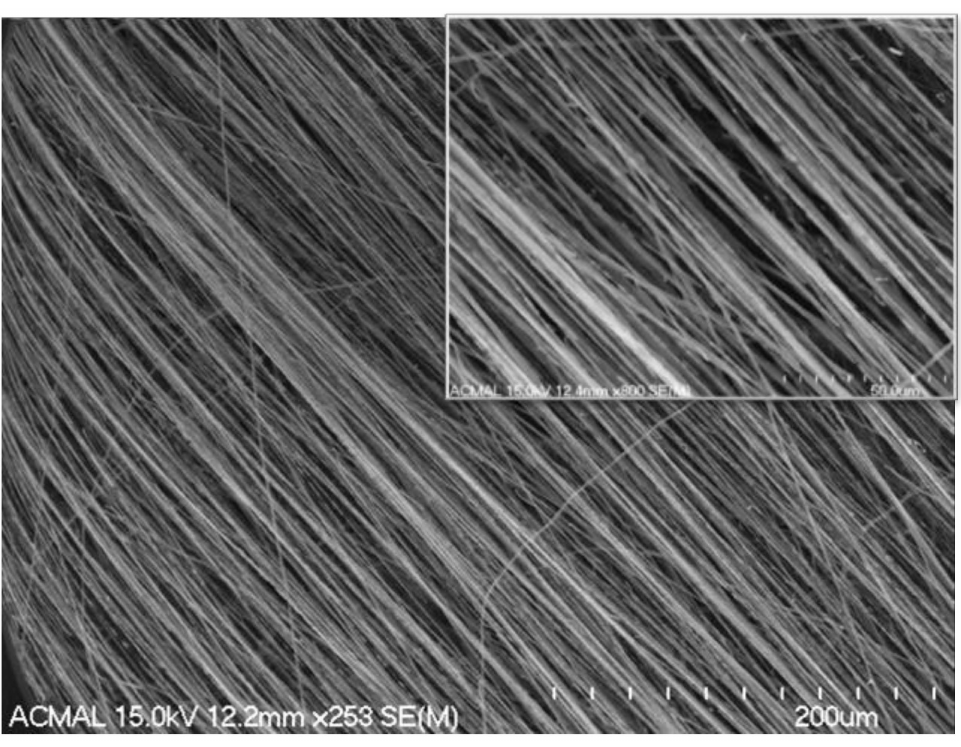
Figure 3. Field Emission Electron Scanning Microscope (FESEM) images of aligned PCL fibers fabricated on a rotating collector. The inset image is a high magnification image showing the alignment and directionalityofthefibers. Adaptedwithpermissionfrom[18], SamerenderNagamHanumantharao,2017.